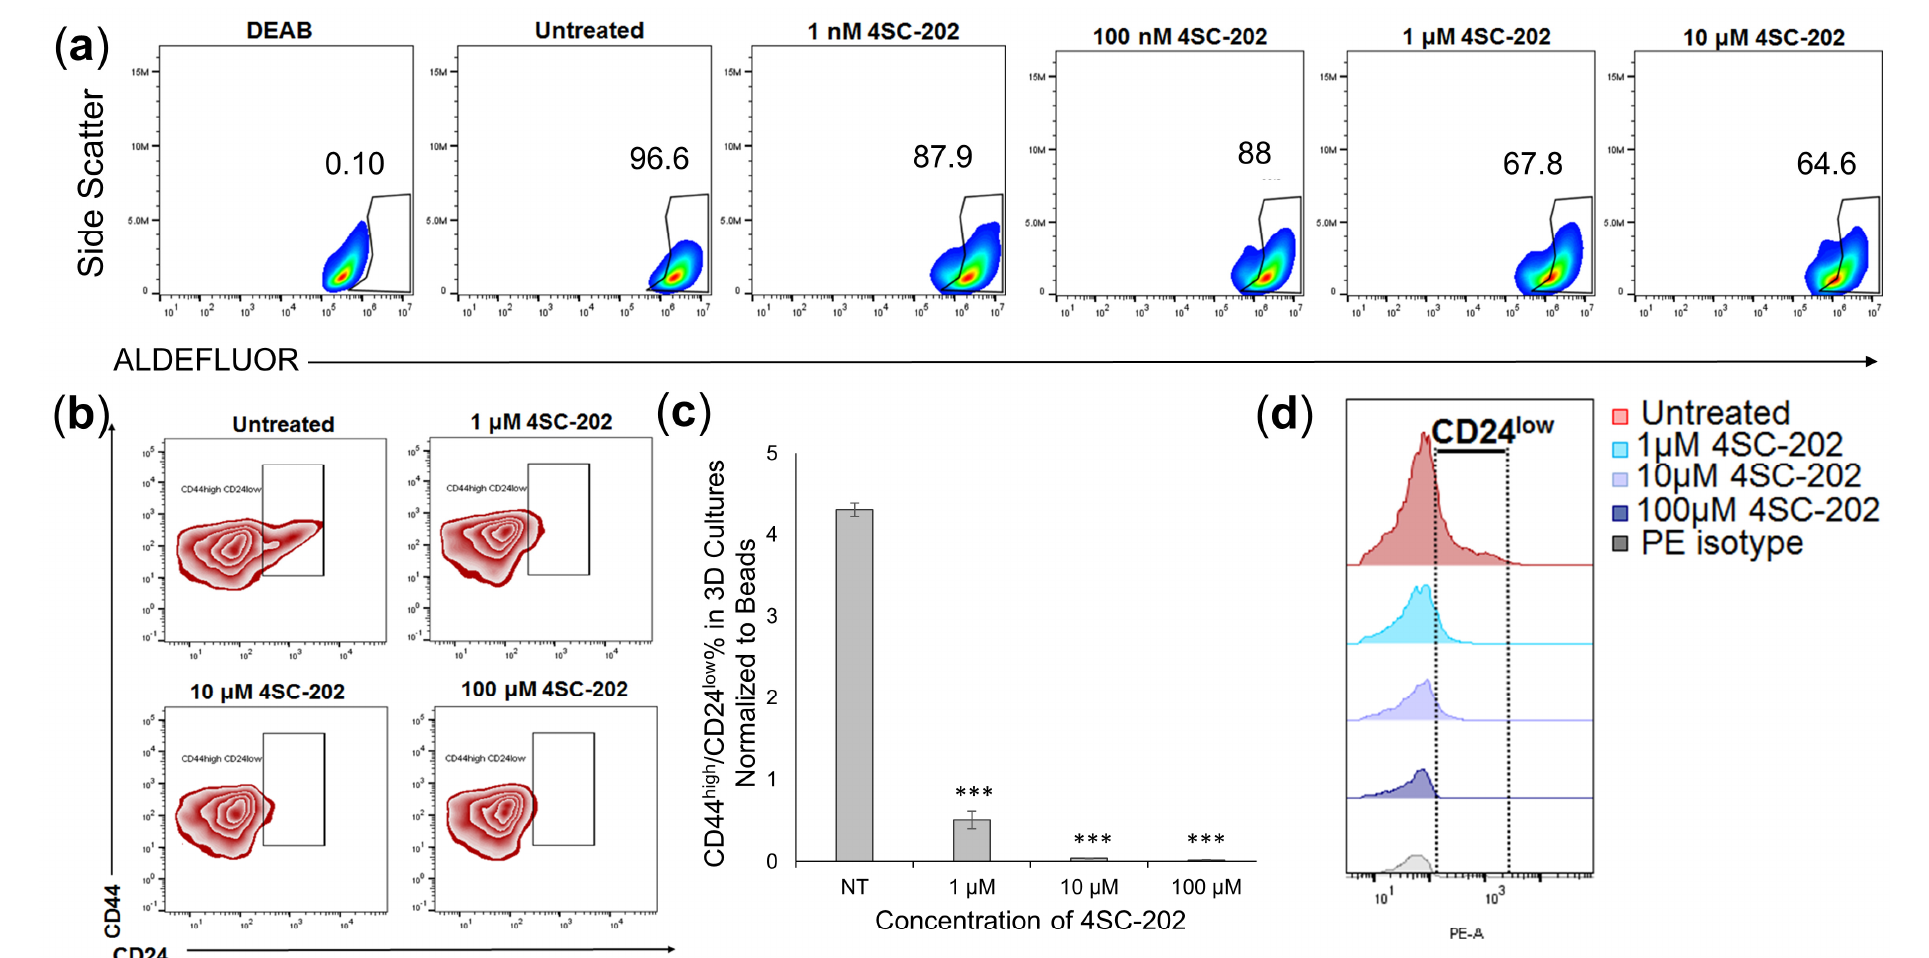
Figure 6. 4SC-202 reduces ALDH high and CD44 high /CD24 low cell populations. ( a ) 4T1 cells were treated with 4SC-202 at the indicated concentrations in the 3D scaffolds and analyzed by flow cytometry for a CD44 high /CD24 low cancer stem cell (CSC) profile. ( b ) Contour plot representing gating strategy, and ( c ) quantification of CD44 high /CD24 low CSC population normalized to beads. Significance is tested using ANOVA followed by a Dunnett’s test for n = 3 scaffold experiments ( p < 0.001 ***). ( d ) Histogram plot revealing loss of CD24 expression with increased